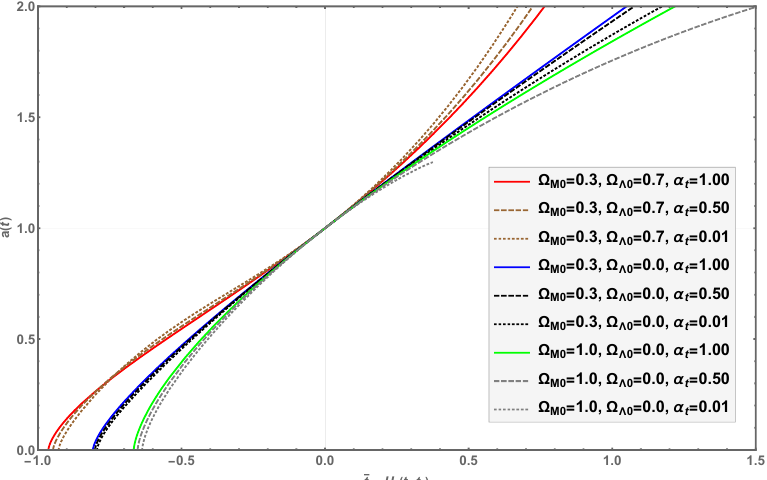
Figure 1. Expansion histories for different values of Ω M 0 , Ω Λ 0 , and of the RFDG parameter α t . Three notable cases from standard cosmology (red, blue, and green solid curves) are compared with RFDG results for similar Ω M 0 , Ω Λ 0 parameters, but with variable α t > 0. RFDG curves for α t = 0.01, 0.50 (dotted and dashed curves) are only slightly different from their respective standard cosmology solid